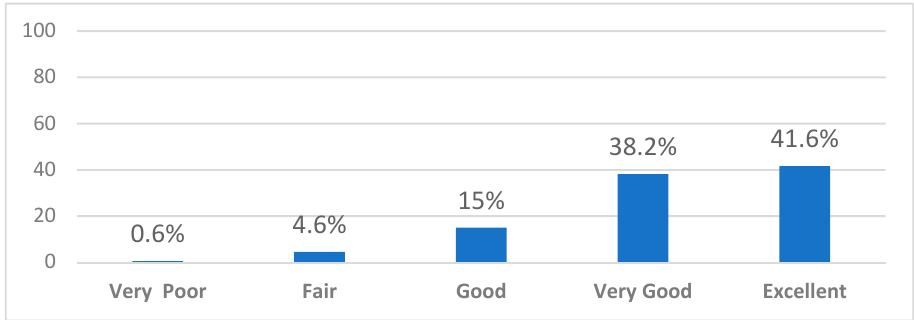
Figure 6. Faculty members overall rating of the virtual interview experience.